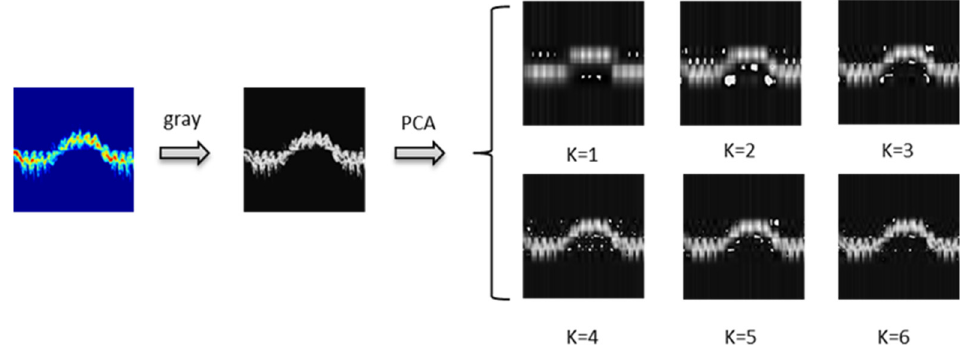
Figure 6. Image Reconstruction in PCA method.